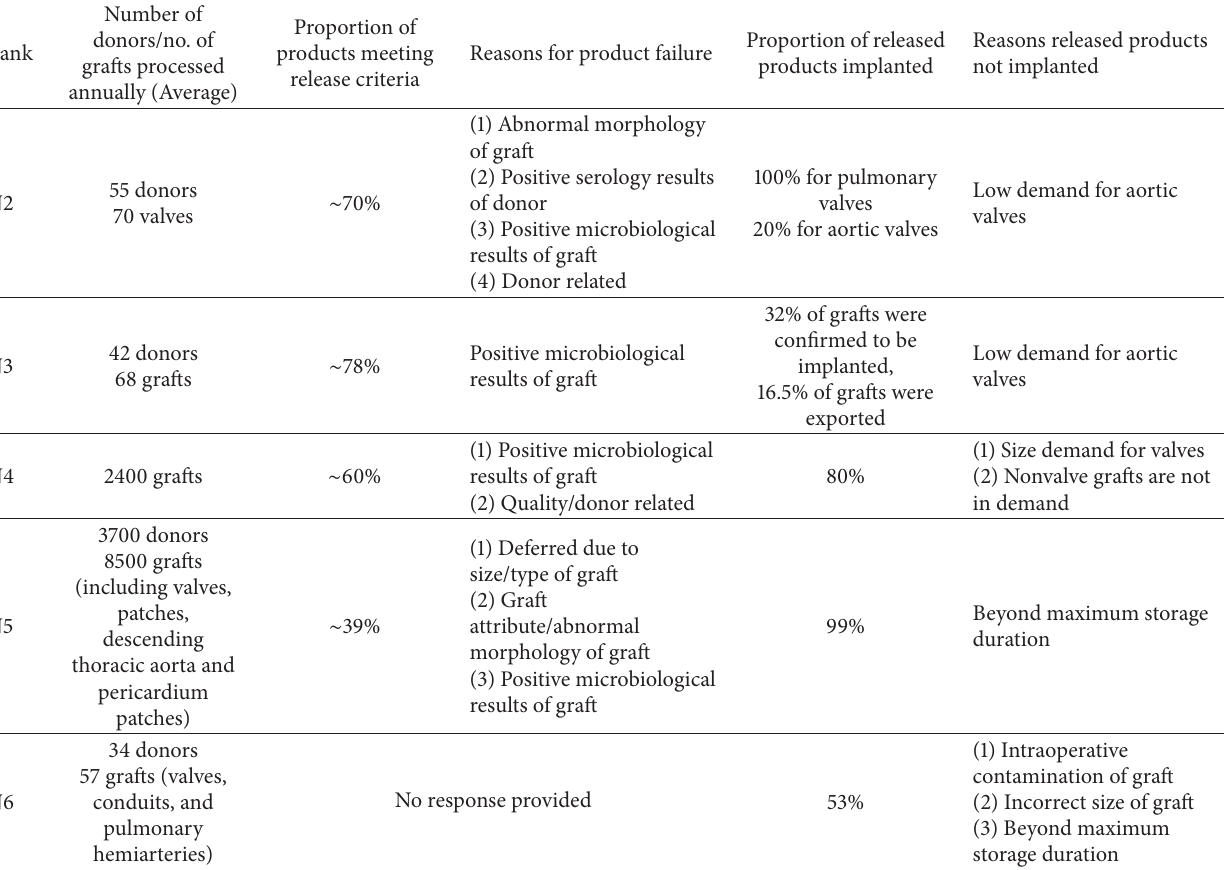
Table 8: Summary of heart valve outcomes for HVBs in North